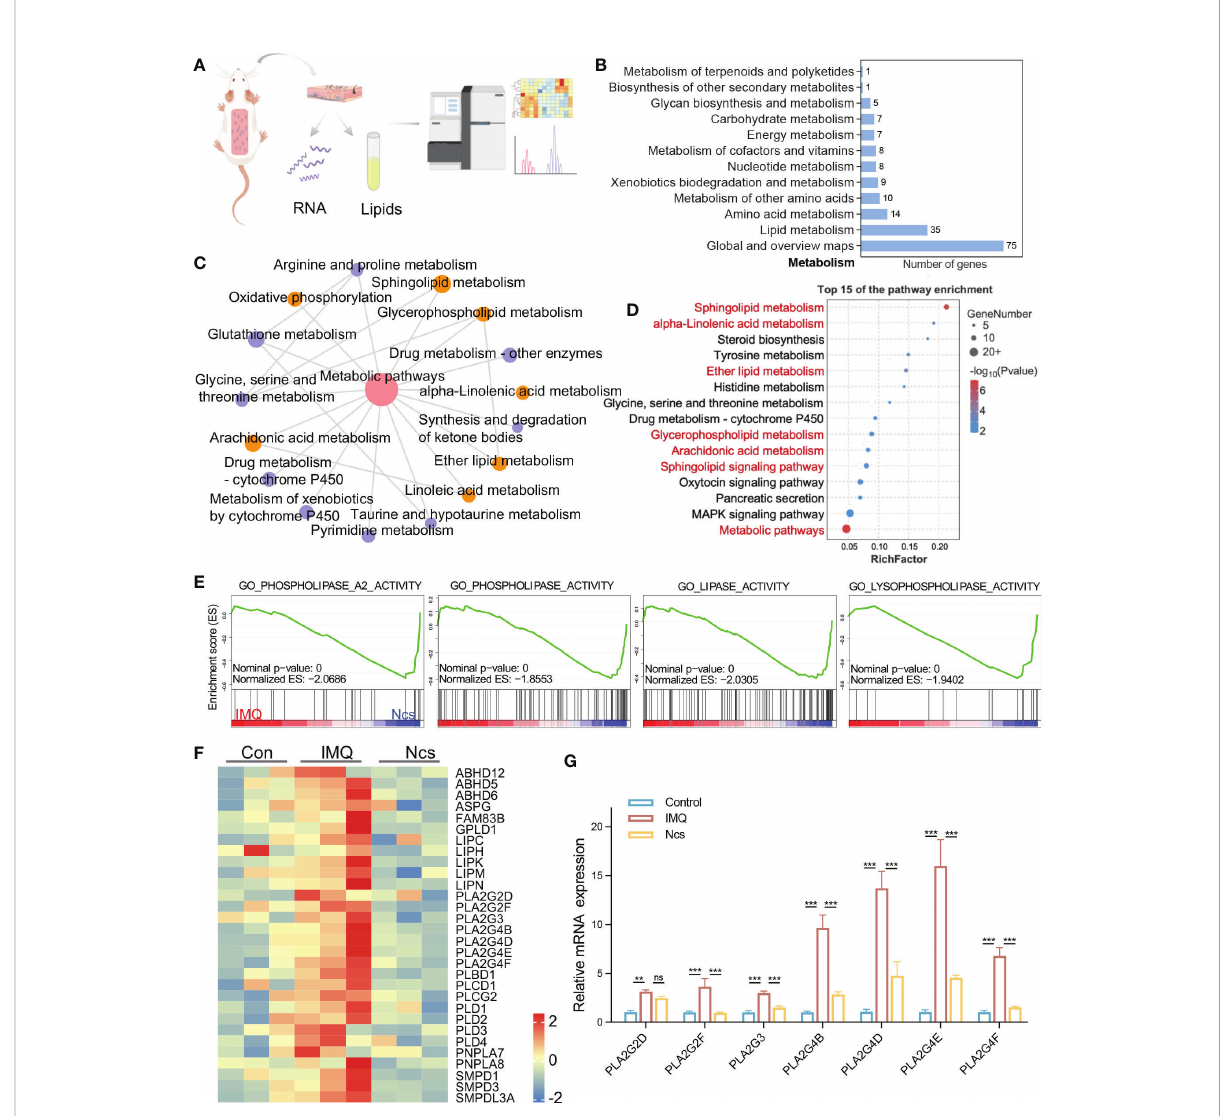
FIGURE 4 Ncs regulated genes involved in lipid metabolism especially phospholipids. (A) A simpli fi ed fl ow chart of the transcriptome and lipidomics. (B) Statistical graph of the number of DEGs enriched in the KEGG metabolic class. (C) Pathway interaction graph with p<0.05 in metabolism class, node size indicates the number of DEGs enriched in this KEEGG pathway. (D) The top 15 results of KEGG pathway. (E) GSEA enrichment plots of GO biological processes related to lipid metabolism in IMQ group and Ncs group. (F) Heatmaps of the DEGs from (E) . (G) PCR veri fi cation of PLA2 family genes in skin of mice (n=3) with different treatments. Data are presented as the mean ± SEM from three separate experiments. P- values were determined using t test by Prism 8; ** p <0.01; *** p <0.001; ns, no signi fi